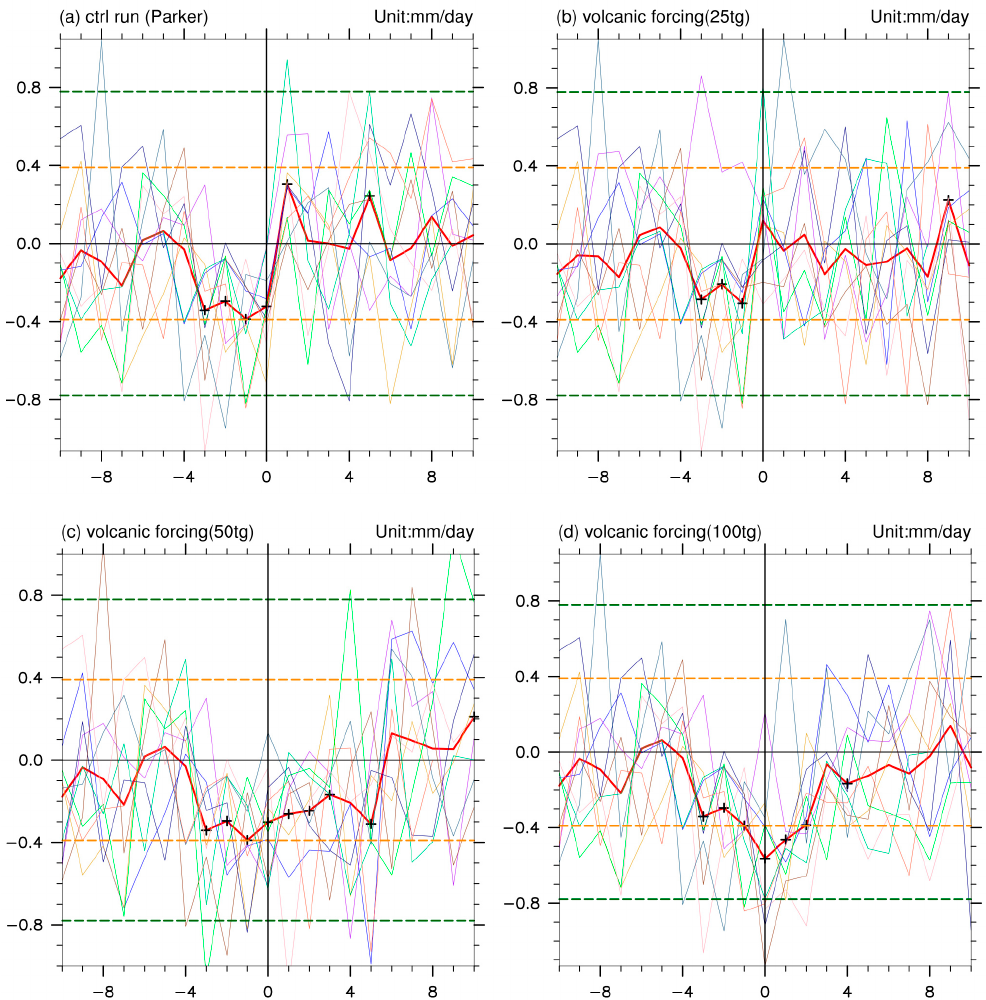
Figure 1. The superposed epoch analysis (SEA) of the annual mean precipitation anomalies (unit: mm / day) from the control experiments ( a ) and volcanic sensitivity experiments of the 25 Tg ( b ), 50 Tg ( c ), and 100 Tg ( d ) volcanic eruptions. The symbol “ + ” indicates that the anomalies are significant at 95% level based on the Student t-test. The orange and green dash lines indicate the ± 1 and ± 2 standard deviations, respectively.